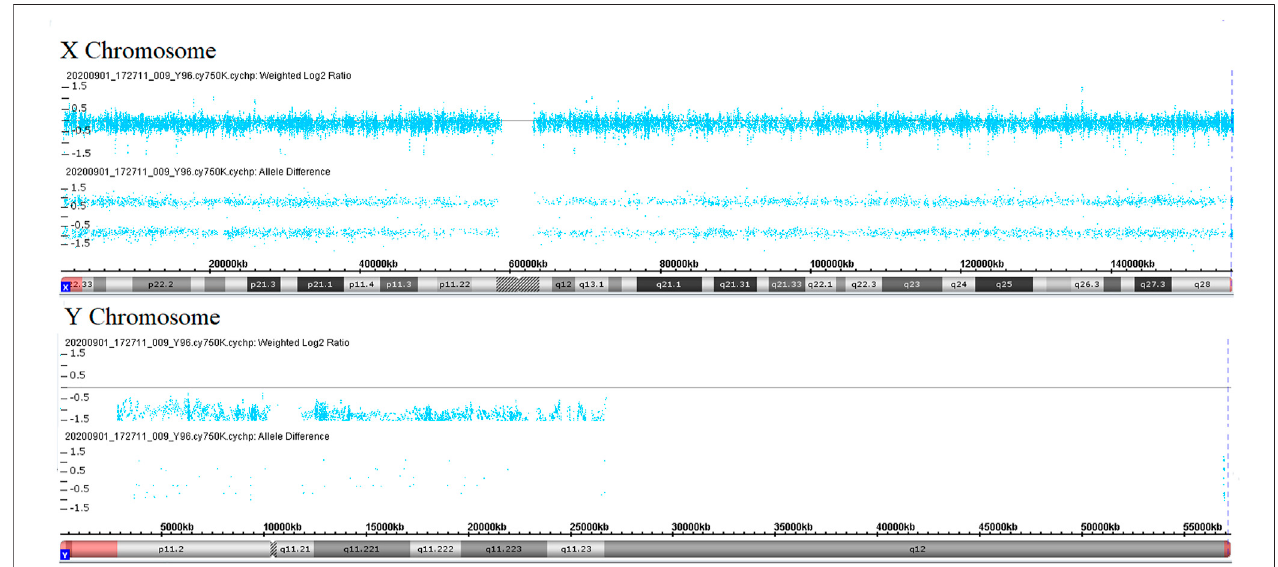
FIGURE 2 | Copy number analyses via CMA. Weighted log2 ratio: values of tested SNP log signal intensity compared to the reference sample SNP intensity are processed through a Bayes wavelet shrinkage estimator, and then these processed values are input to the CNState algorithm HMM; intensity ratio of 0 = 2 copies; intensity ratio of − 1 = 1 copies; values of chromosomes X and Y are centered below 0 and − 1, respectively, indicating sex chromosome mosaicism. Allele difference is computedbasedondifferencingAsignalandBsignal;genotype “ AA ” :(0.5+0.5) – (0)=1;genotype “ AB ” :(0.5) – (0.5)=0;genotype “ BB ” :(0) – (0.5+0.5)= − 1;values of chromosome X indicates maternal uniparental disomy of chromosome